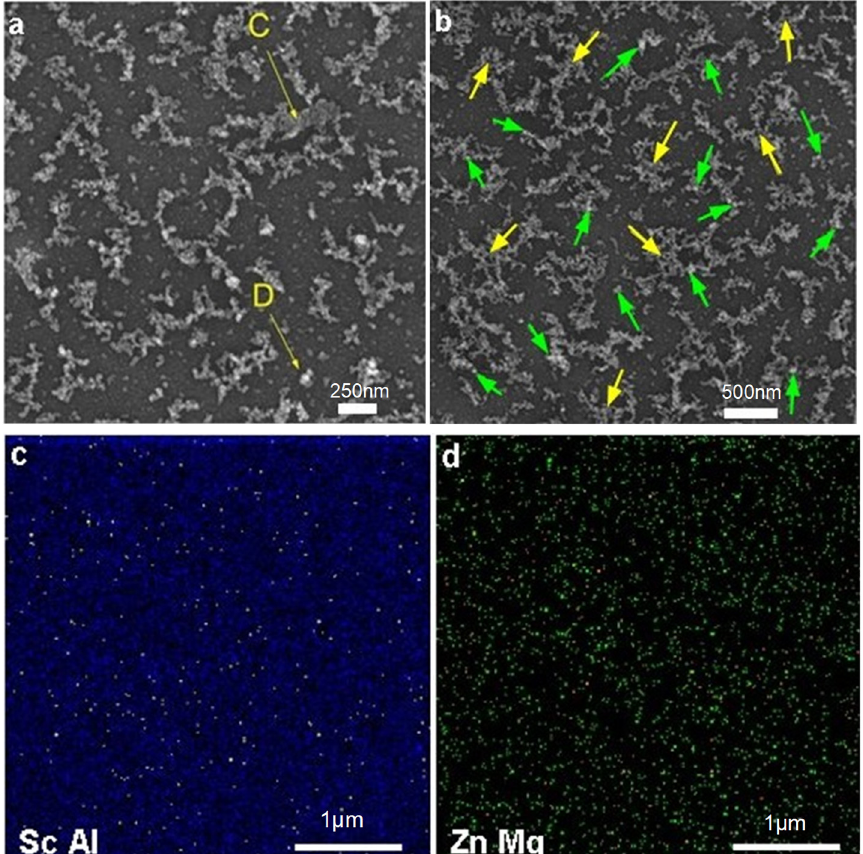
Figure 9. Distribution of MgZn 2 and Al 3 (Sc,Zr) precipitates in Al matrix in the alloy containing 0.1% Sc, under thermomechanical treatment with controlled quenching and 50% rolling: ( a , b ) Distribution of MgZn 2 and Al 3 (Sc,Zr) precipitates, ( c ) element distribution maps of Al-Sc elements, and ( d ) element distribution maps of Zn-Mg elements.